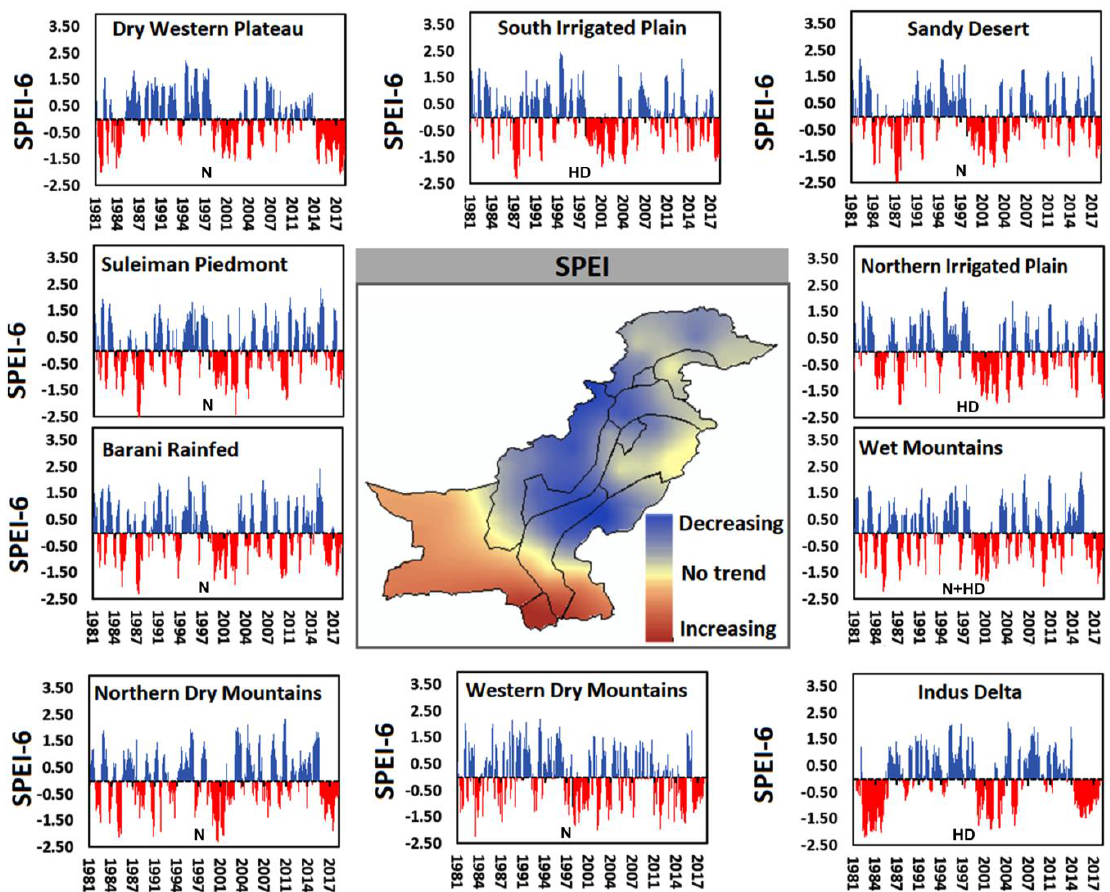
Figure 2. Spatial trend and time series of the standardized precipitation evaporation index at a six- month timescale (SPEI-6) over different AEZs. Note: N and HD represent natural and human-disturb zones, respectively.